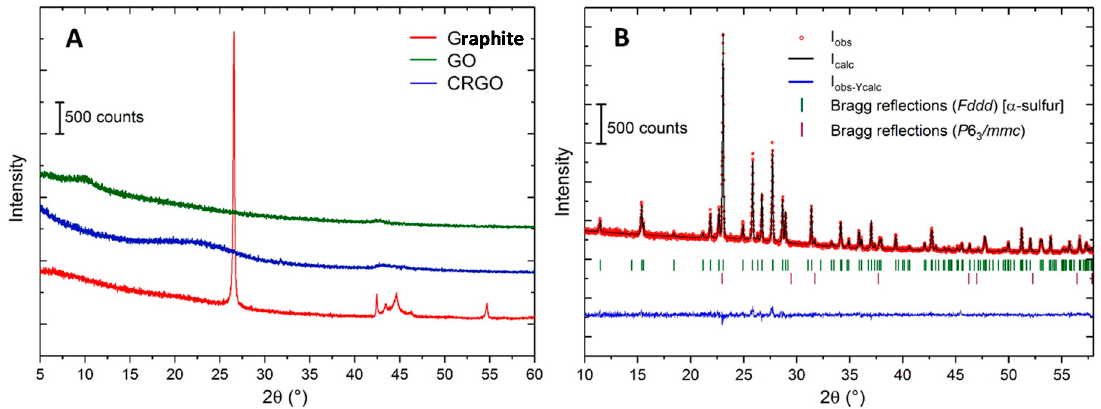
Figure 4. X-ray diffraction of the materials used for fabrication of the cathode in Li-S battery. ( A ) Graphite, GO and CRGO; ( B ) Rietveld analysis of the GS2 composite with α -sulfur ( Fddd ) along with the hexagonal P 6 3 / mmc graphitic phase.